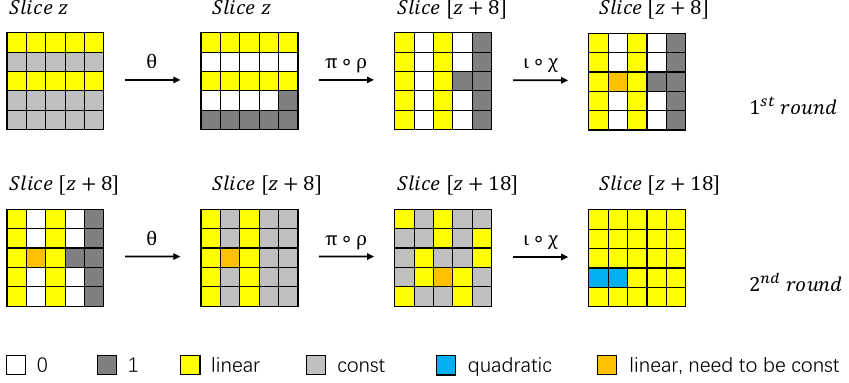
Figure 7: A case of effects caused by one unsatisfied restriction of